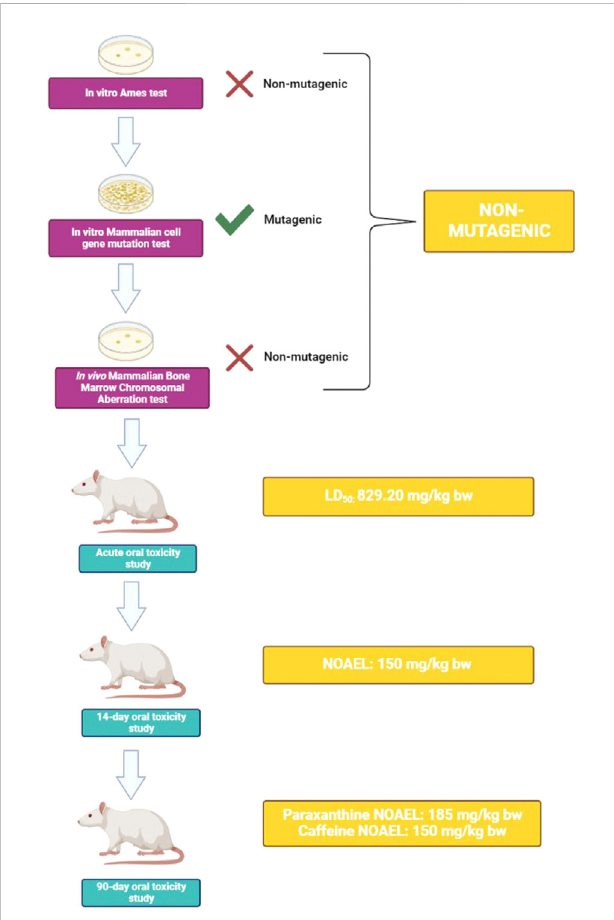
FIGURE 6 Schematic summary of experimental fi ndings. Results from a battery of genetic toxicity tests demonstrate that paraxanthine is non- mutagenic. In an in vivo test, acute toxicity experiments derived an LD 50 of 829.20 mg/kg bw for paraxanthine. Upon repeated exposure to paraxanthine in a 14-day study, a NOAEL of 150 mg/kg bw was derived. Lastly, in the 90-day subchronic oral toxicity study, the toxicity of paraxanthine and caffeine were compared. Paraxanthine demonstrated a better toxicity pro fi le compared to caffeine, as the established NOAEL was 185 mg/kg bw compared to that of caffeine at 150 mg/kg bw. This fi gure was created using